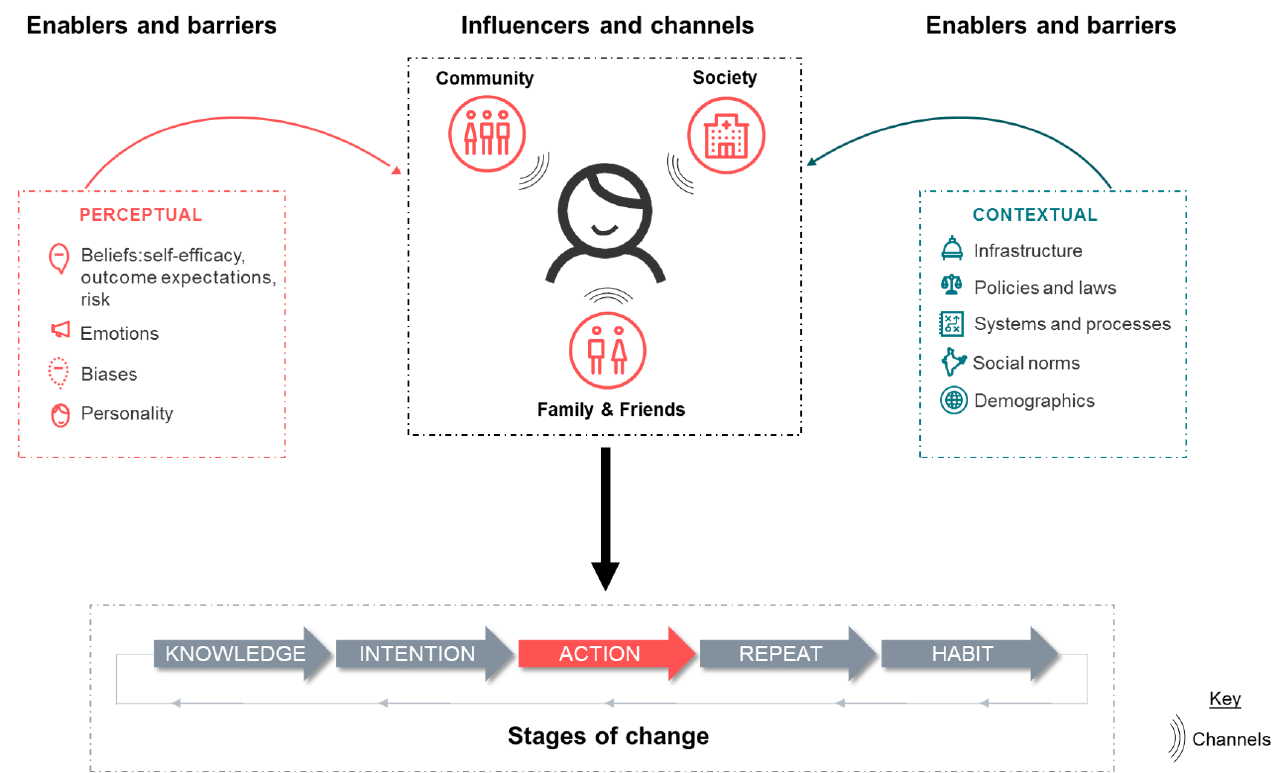
Figure 1. The CUBES behavioral framework. Contextual and perceptual drivers combine to act as enablers and barriers along an individual’s path from knowledge – encompassing awareness and skills – to intention (or motivation to act towards a goal) and action and beyond. Layers of influencers can affect these drivers and reach an individual through various